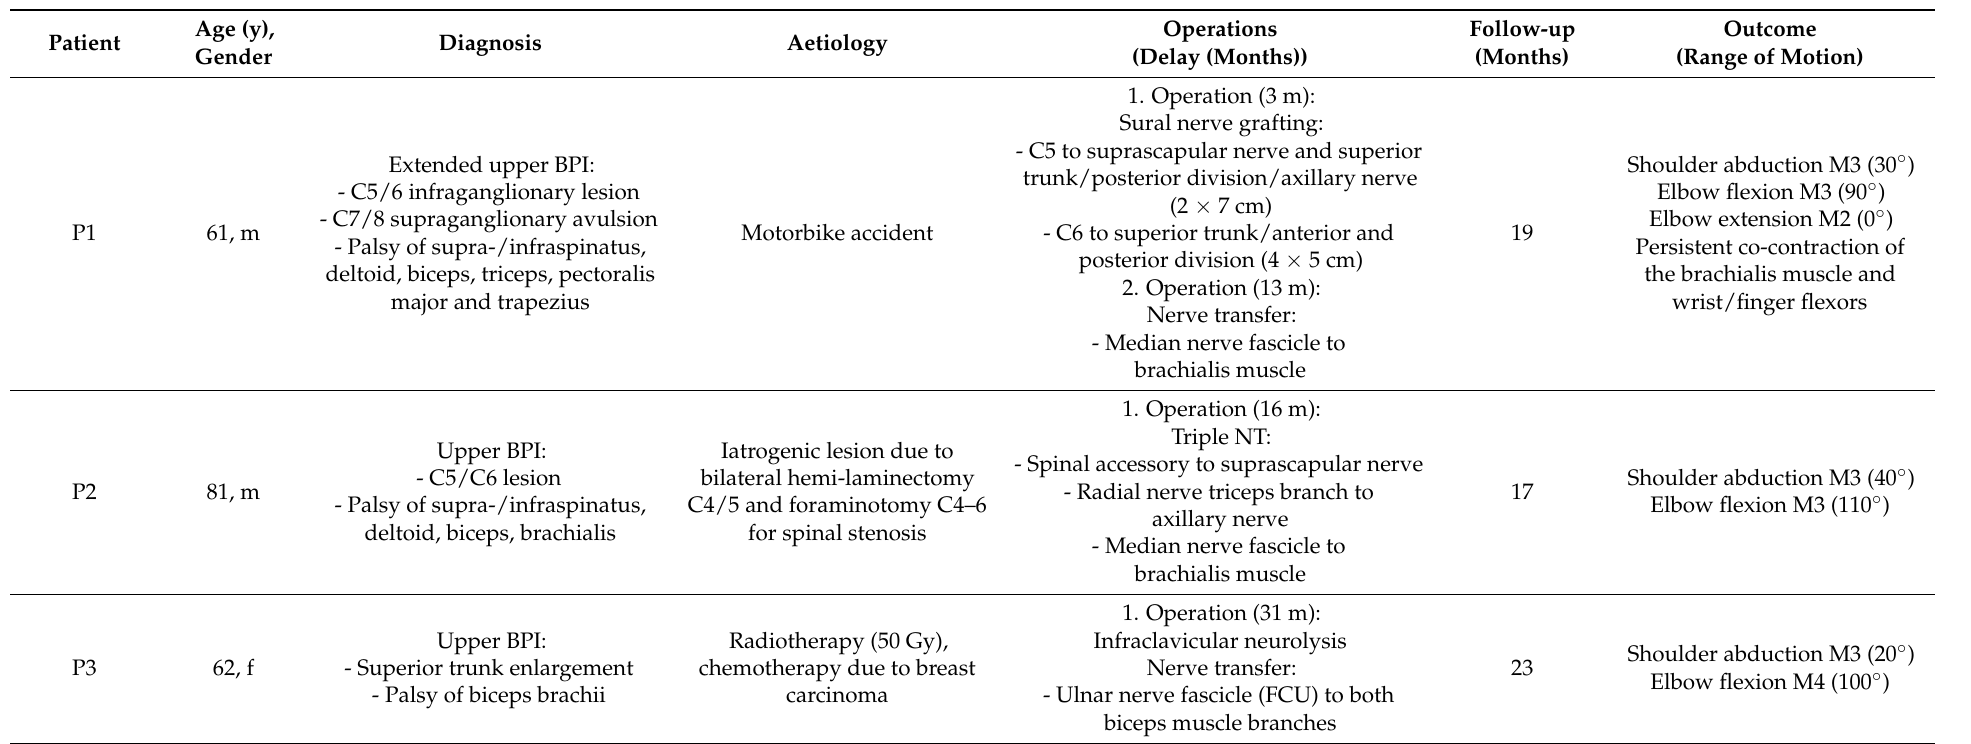
Table 1. Patient characteristics and